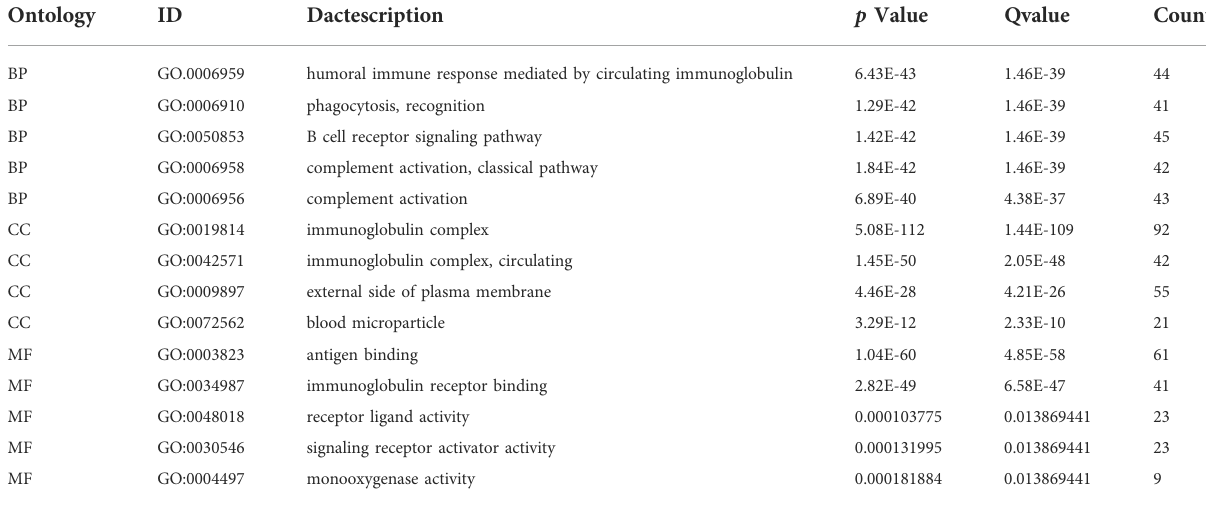
TABLE 4 The top 14 GO enrichment